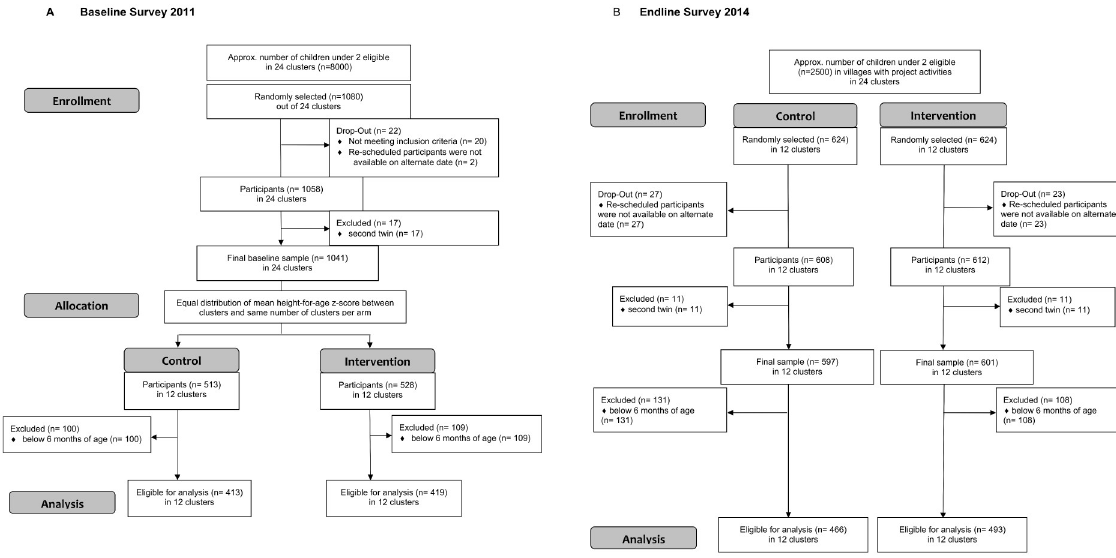
Fig 1. CONSORT flow diagram for (A) Baseline survey 2011and (B) Endline survey